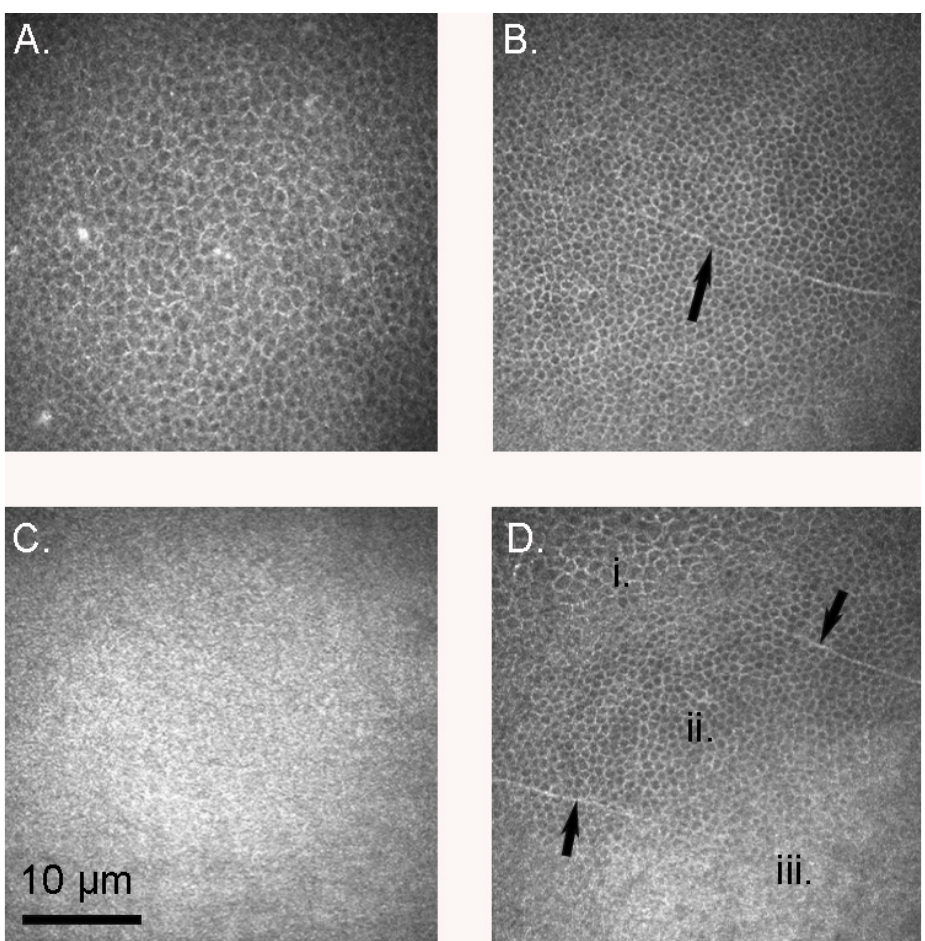
Figure 1. The corneal epithelium of gentoo penguins Pygoscelis papua . ( A ) Superficial epithelium (G1, left eye); ( B ) Basal epithelium (G3, left eye). Note the peripheral nerve (arrow); ( C ) Bowman’s membrane (G2, left eye); ( D ). A section (G3, left eye) sliced diagonally to show the superficial epithelium ( i ), basal epithelium ( ii ) and Bowman’s membrane ( iii ). Note how the superficial cells appeared larger in cross section than their basal counterparts, and thus less dense. Arrows indicate peripheral